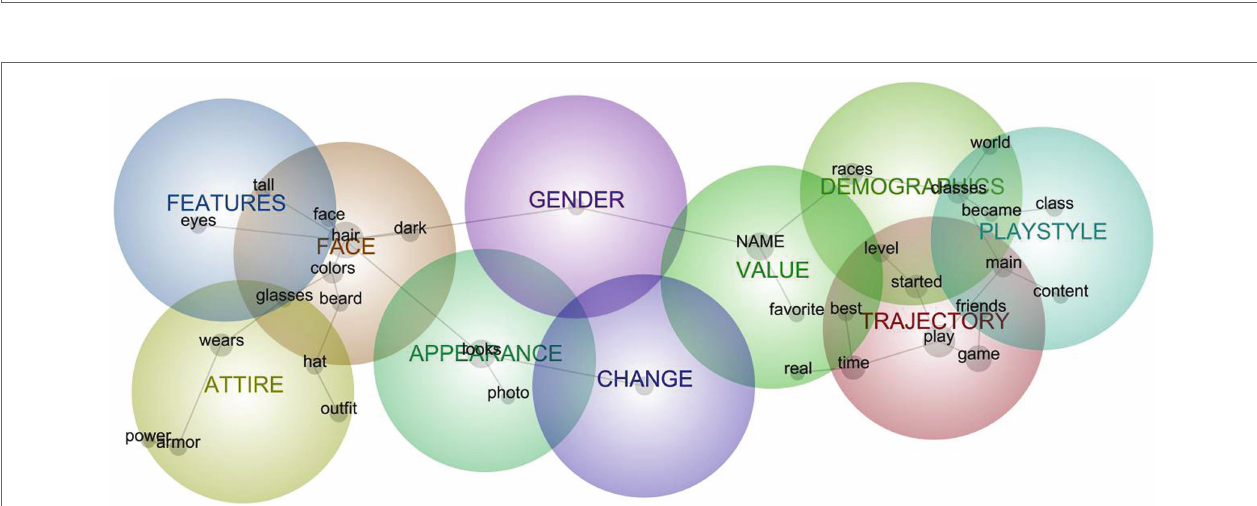
FIGURE 1 | Semantic network model for aggregated descriptions of avatars in Object relations.